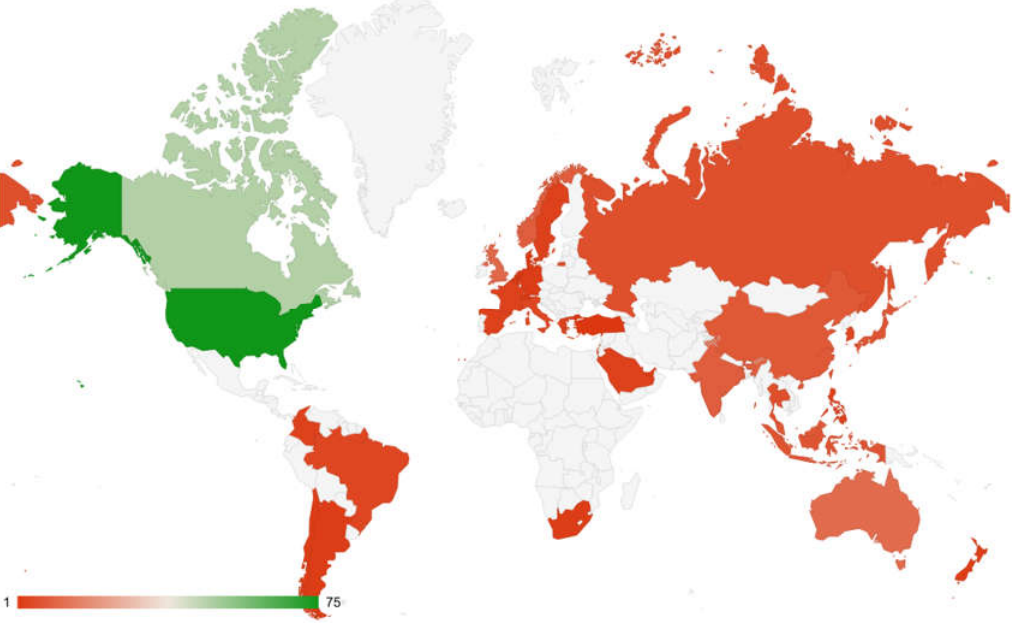
Figure 3. The energy companies worldwide. The color scale ranges from green, which represents the highest count of companies (75), to red, which represents the lowest count of companies (1).